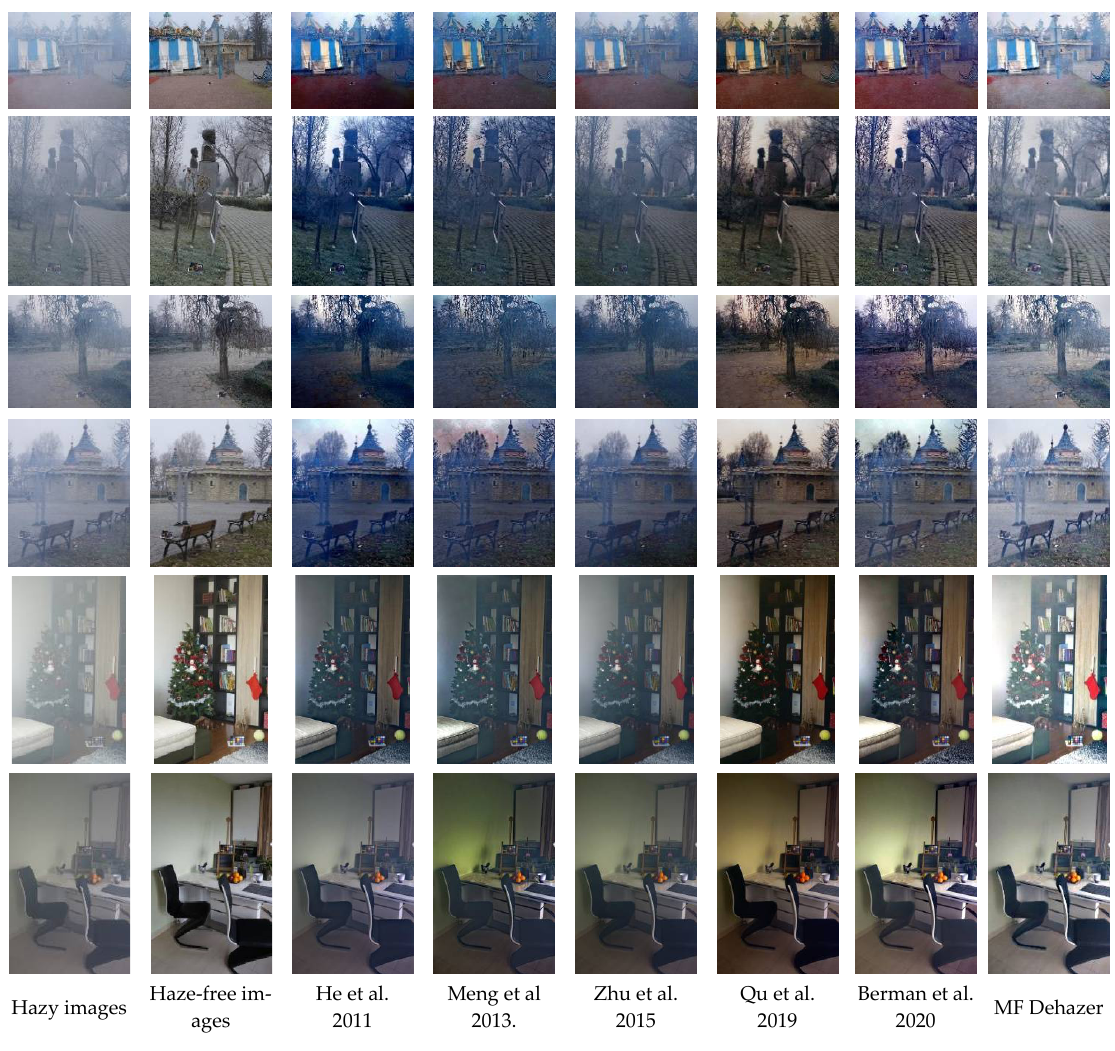
Figure 7. Comparison of O-HAZE and I-HAZE [9,12,14,15,21]. Table 3. Comparision Index Of O-Haze Additionally, I-HazeE.